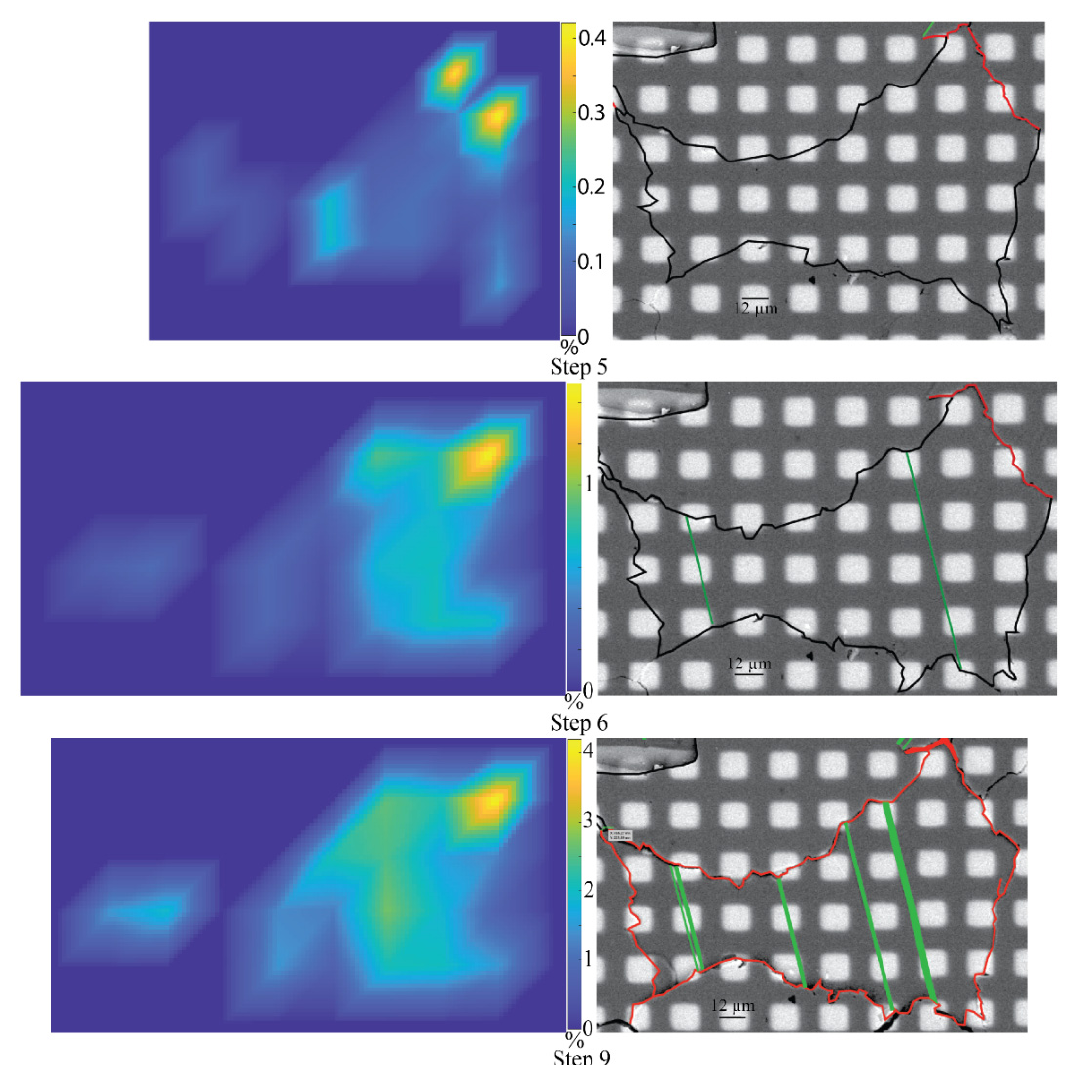
Figure 17. Equivalent Von Mises deformation map of crystal 10 at different steps of sample defor- mation. The black lines represent the grain boundaries. The green lines show the twinned planes. The red lines show the fracture zones.